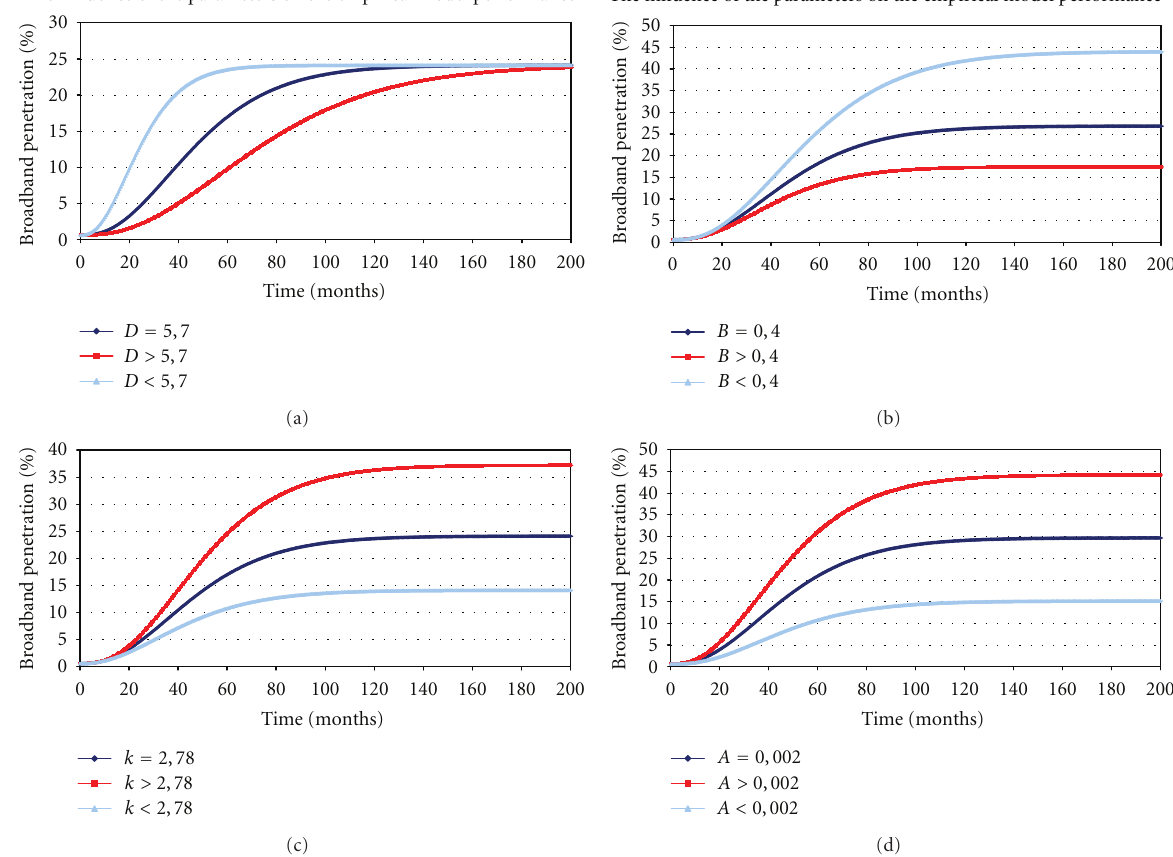
The influence of the parameters on the empirical model performance